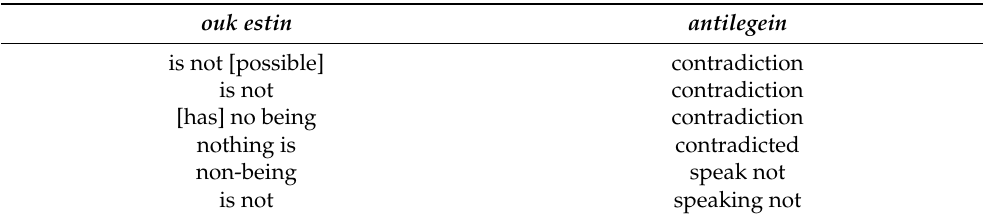
Table 1. Interpretations of the “contradiction is impossible” doctrine. ouk estin antilegein is not [possible] contradiction is not contradiction [has] no being contradiction nothing is contradicted non-being speak not is